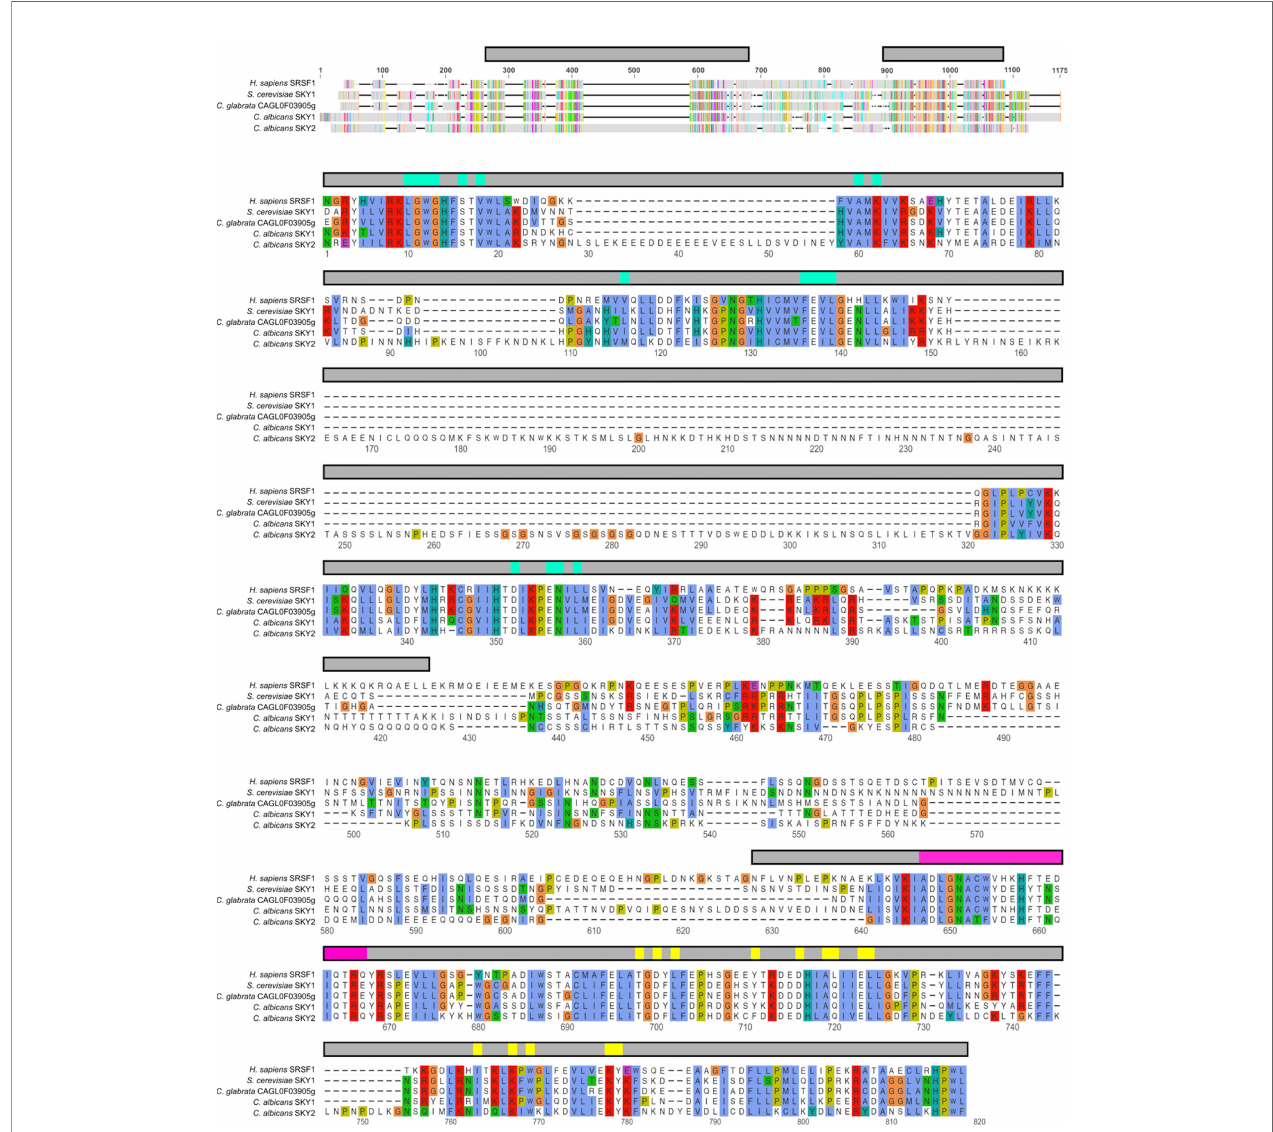
FIGURE 1 | Protein alignment of SRPK homologs: H. sapiens SRPK1, S. cerevisiae Sky1, C. glabrata Sky1, and C. albicans Sky1 and Sky2. The annotation of the protein features (the bars above the corresponding alignment section) is based on the annotation of the human SRPK 1 (NP_003128.3). Upper graph: Overview alignment of the entire protein, where the kinase domains are indicated by the grey bars above. Lower graph: Detailed alignment of the kinase domain (grey bar above) intercepted by the ‘ spacer ’ region. The protein kinase domain contains ATP binding sites (turquoise), activation loop (magenta) and kinase-docking sites (yellow). All regions required for SRPK1 function are highly conserved among the fungal species. The conserved alignment sites are highlighted within the alignment applying Clustal X default